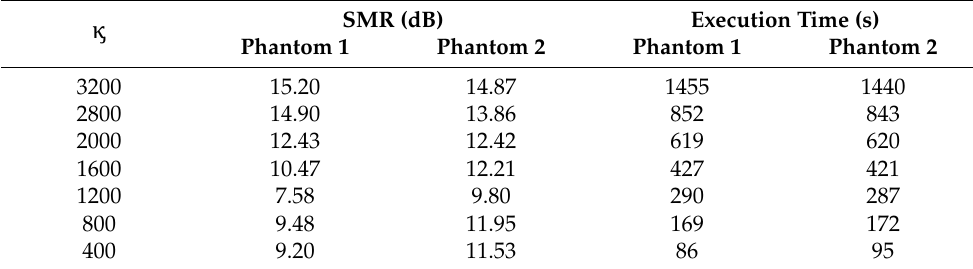
Table 2. Comparison of the execution time with the methods presented in the